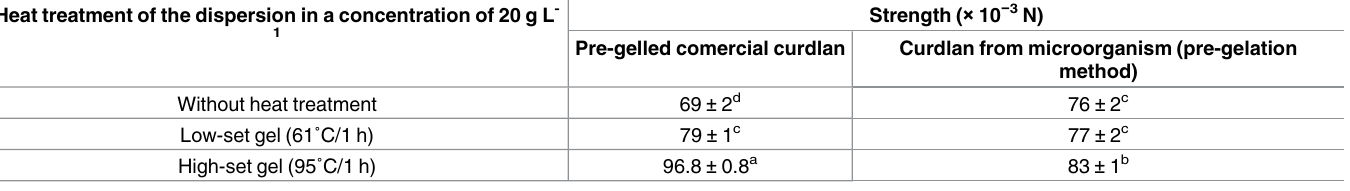
Table 2. Strength ( × 10 − 3 N) of pre-gelled commercial curdlan and the curdlan produced by Agrobacterium sp. IFO 13140 (pre-gelation method) samples after undergoing different heat treatments. Values indicatemean ± standard-deviation. Heat treatment of the dispersion in a concentration of 20 g L -